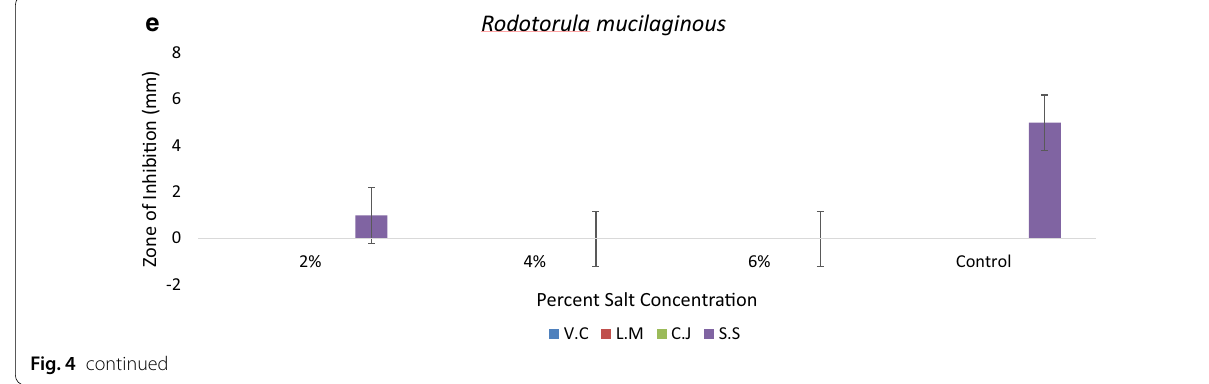
Table 7 Effects of carbon source on the antimicrobial activities of yeast isolates Zone of inhibition